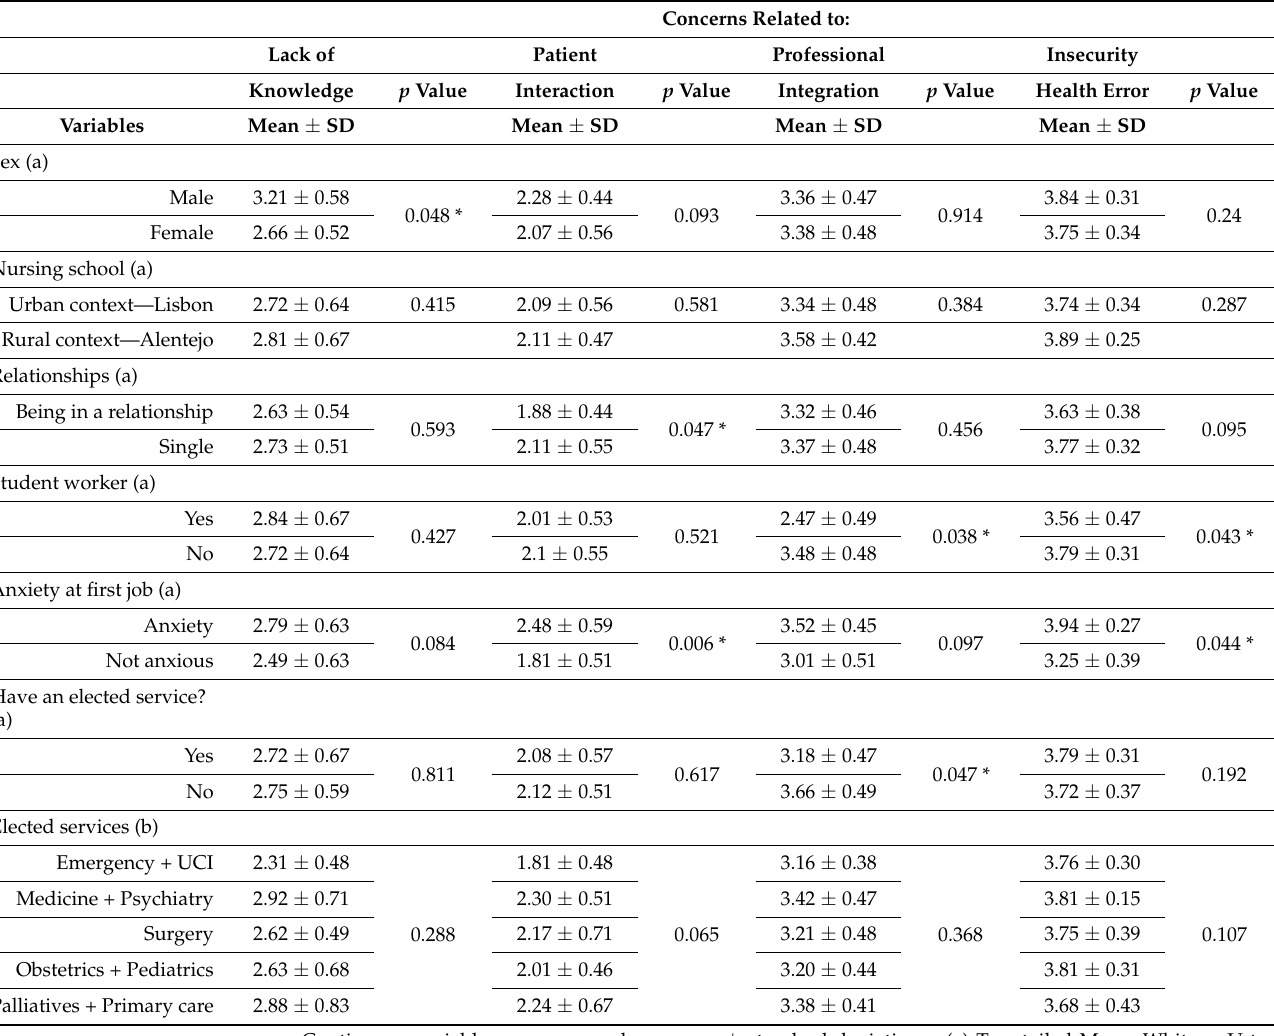
Table 5. Mean values and standard